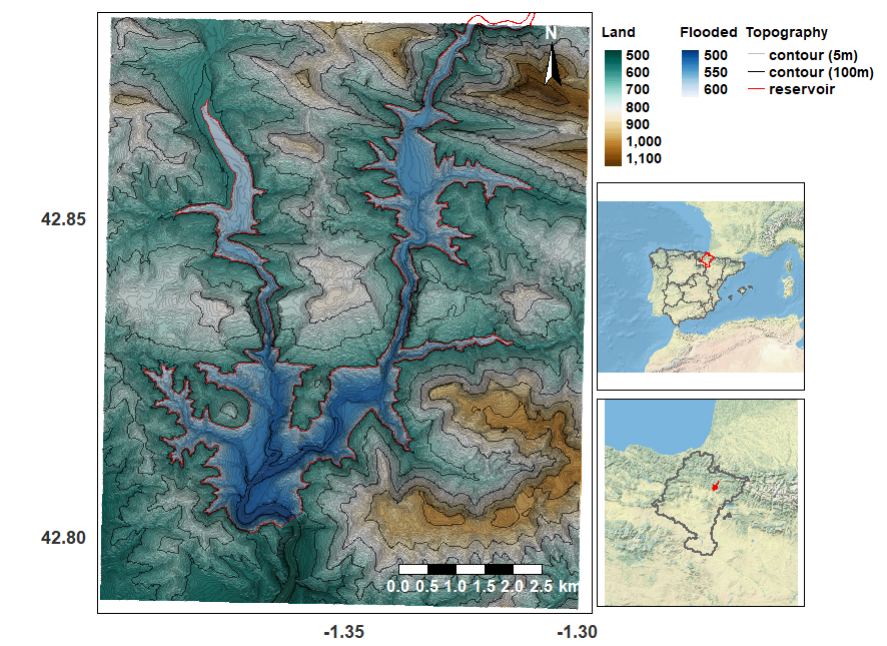
Figure 1. Elevation map of the study region, including the Itoiz reservoir basin. The map on the left represents the original contour map in grey, and black lines show five and 100 meter variations in altitude. The continuous color code displays the gridded altimetry interpolated at a 10 × 10 m 2 resolution from the topographic map. The maps on the right, from top to bottom, display the location of Navarre (red border) in Spain and the location of the reservoir (Itoiz) within